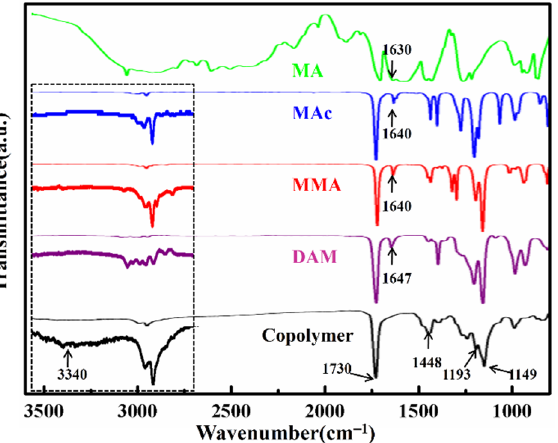
Figure 2. FTIR spectra of monomers (MA, MMA, Mac, and DAM), compared with the copolymer (MMA-MAc-DAM-MA).